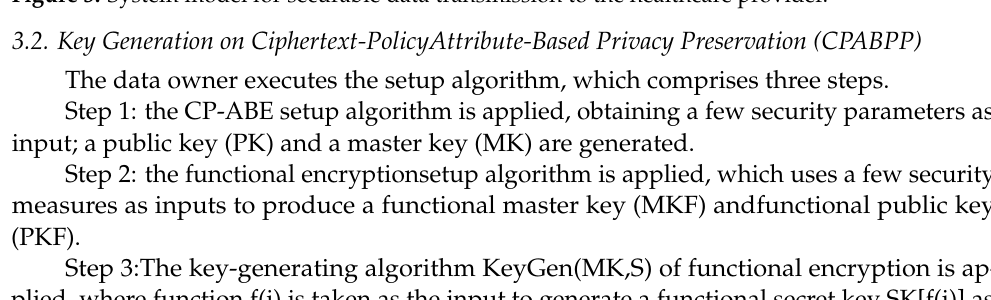
Figure 3. System model for securable data transmission to the healthcare provider.